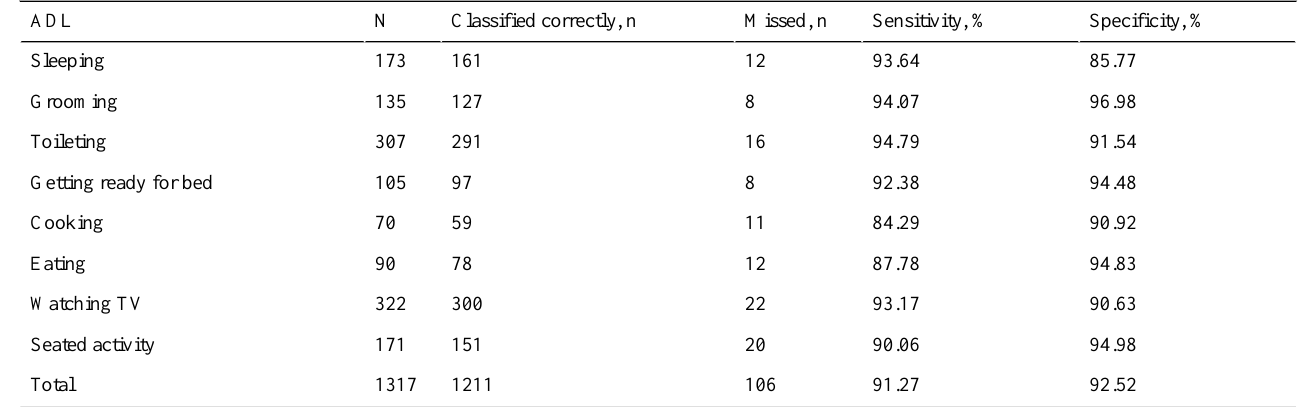
Table 3. Results of the ADL